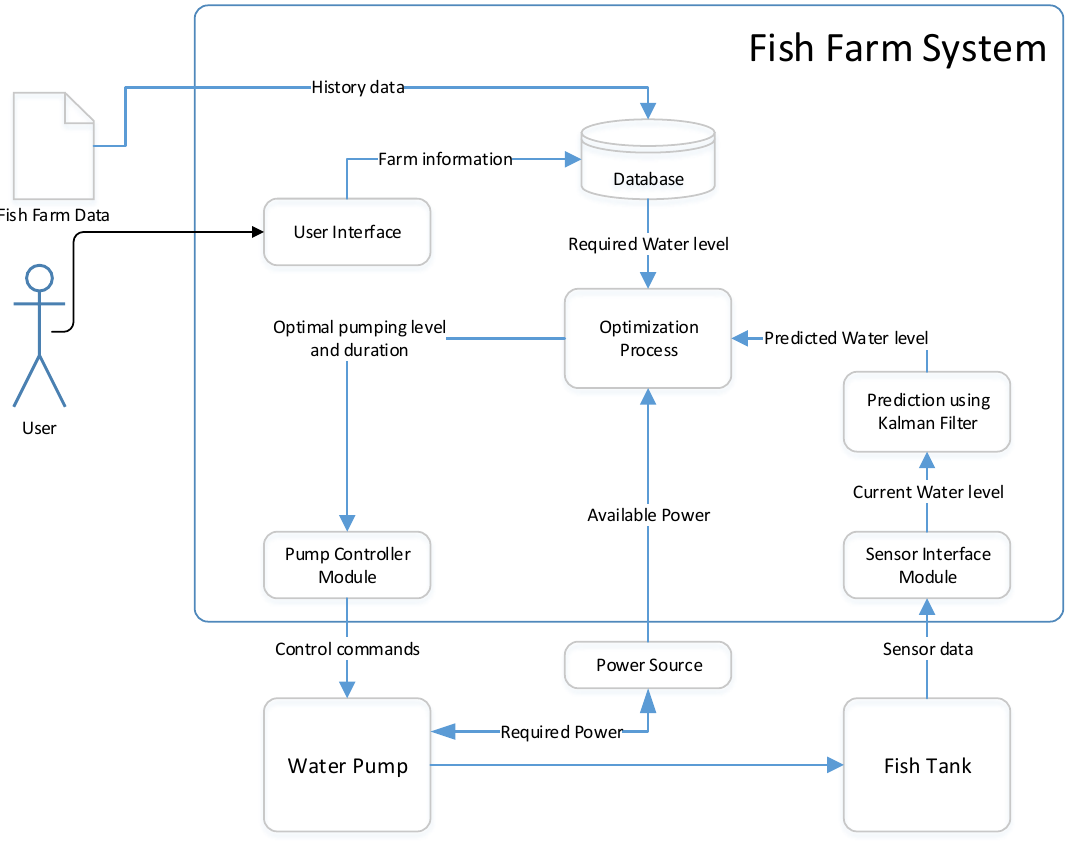
Figure 10. Operational sequence of prediction, optimization and control in smart fish